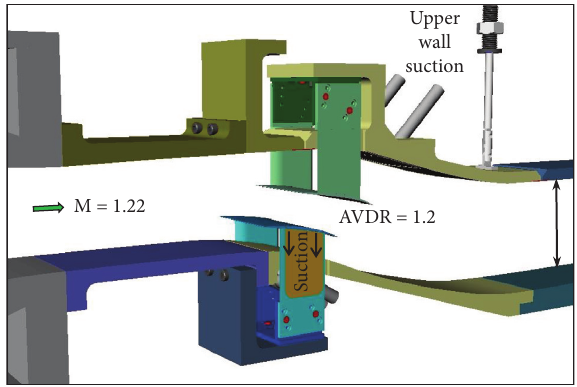
Figure 2: Single-passage compressor cascade